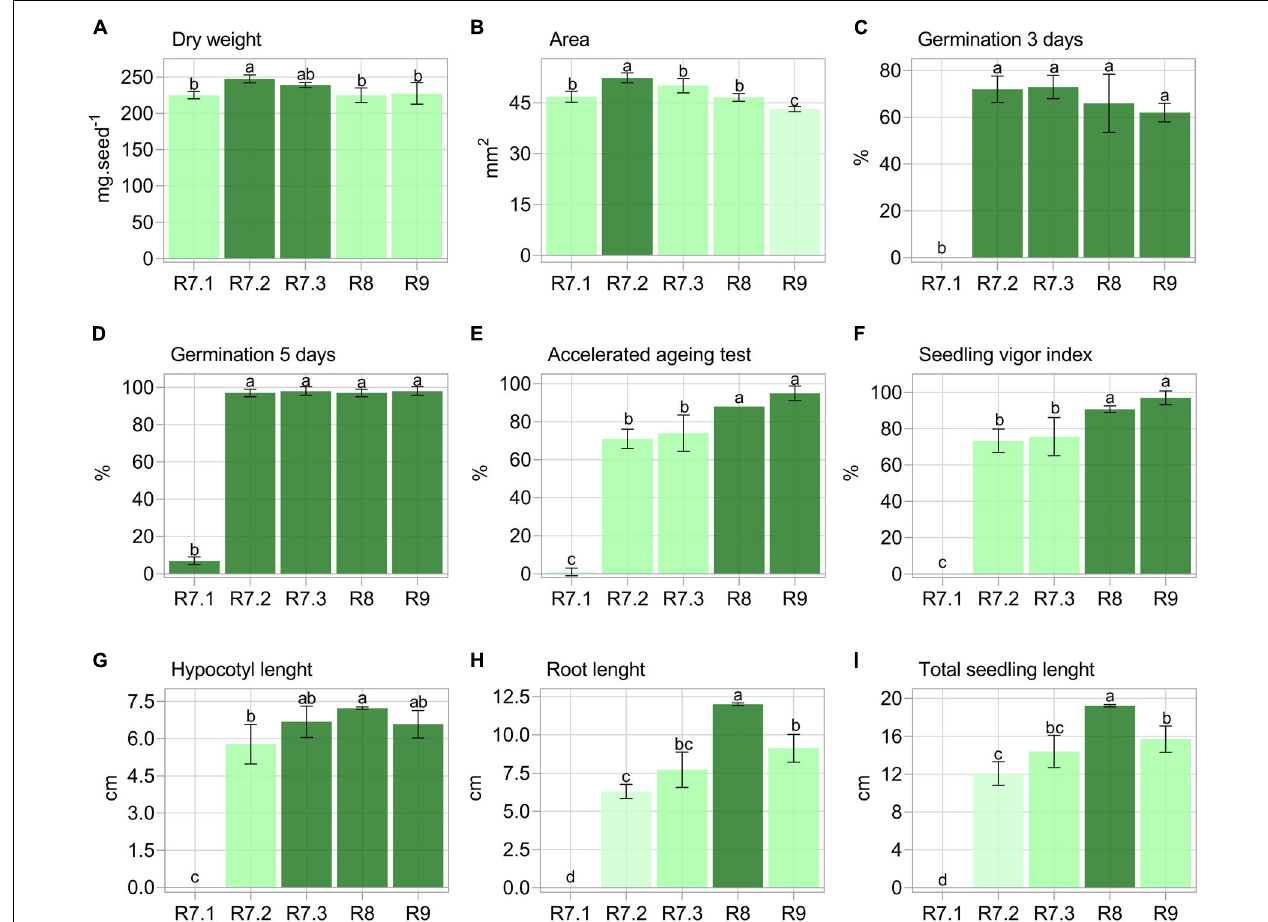
FIGURE 2 | Physical and physiological properties of soybean seeds from different maturation stages. Each bar represents the mean of four replicates of 25 seeds ± standard deviation. Different letters indicate significant difference ( α = 0.05) by Tukey test ( n = 20).